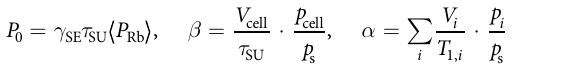
where α is the same definition as the one described in Eq. 26. The experimental data were fitted by using Eq. 27 with P 0 and τ − SU1 as fitting parameters. The α was also set as a fitting parameter for the data obtained from the experimental data at p cell = 101 kPa whereas α = 8.4 sccm was used for that at p cell = 15 kPa, which was measured as α dil as described in the previous section. The values of V cell = 848 cc was used in the analysis. The observed P Xe,meas and fitted curves are shown in Fig. 5, and the estimated values from the fit are listed in Table 3 (upper). The two cell pressures using relations of Eqs 3 and 4. In the calculation, literature values of ξ Xe and 〈 σ v 〉 , and the num- ber densities of atoms calculated for our experimental condition listed in Table 3 (lower) were used. The estimated values were ξ ib = 2.61 × 10 3 s − 1 and Γ Xe = 1.84 × 10 − 4 s − 1 .